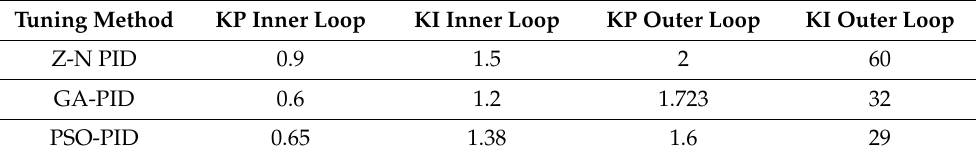
Table 1. PID Optimized Parameters.